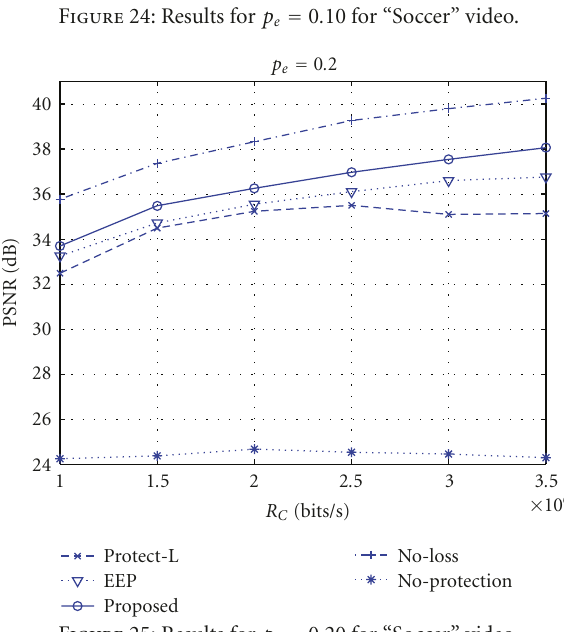
Figure 23: Results for p e = 0 . 05 for “Soccer” video.